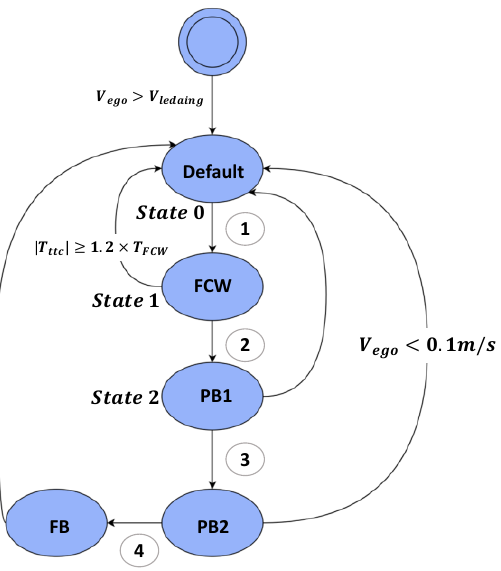
Figure 8. The AEB system ’ s state chart.